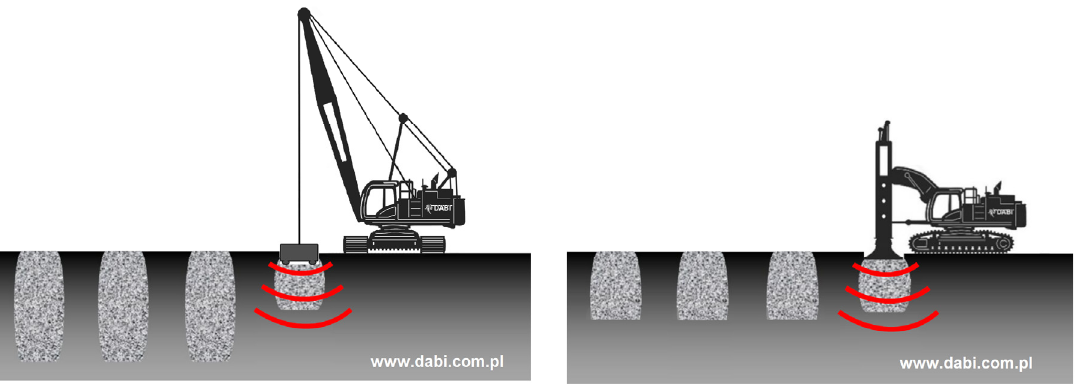
Figure 17. Graphics showing the formation of stone columns by the Dynamic Replacement method (DR, on the left ) and the formation of stone columns using the impulse compaction technology (on the right ) (Graph. By P. Dobrzycki).